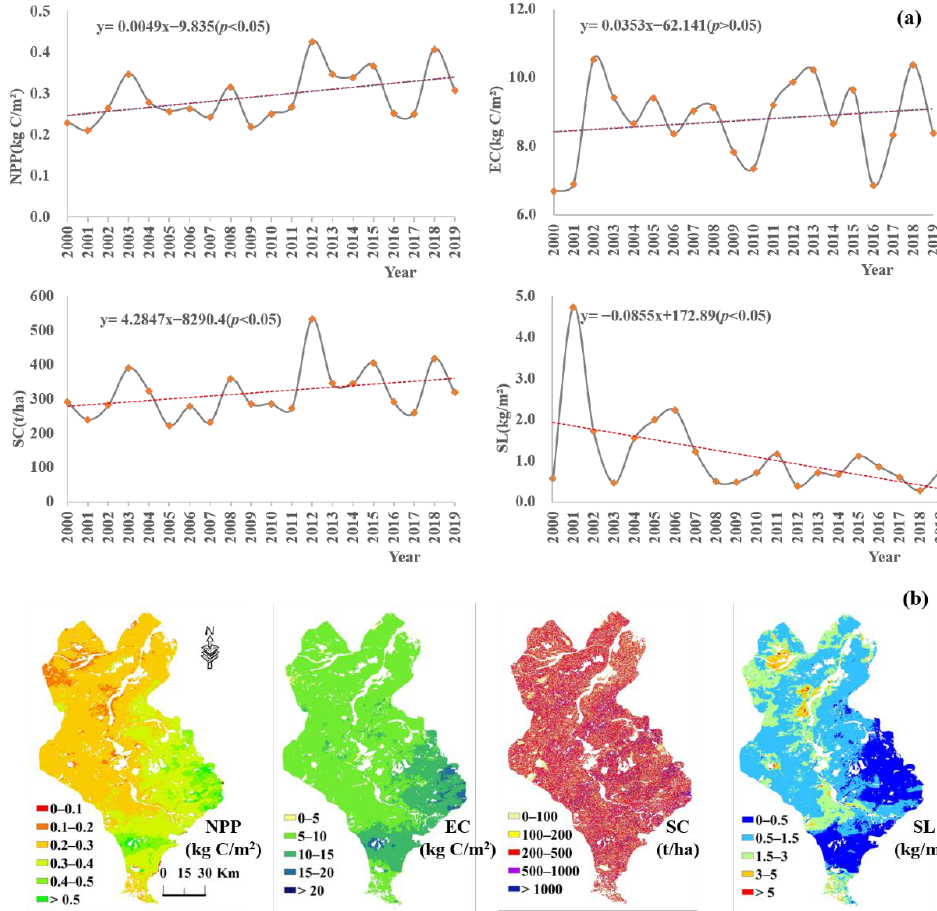
Figure 4. Spatiotemporal of ecosystem services in the study area, from 2000 to 2019. ( a ) Interannual variability; ( b ) spatial distribution of the average value of ecosystem services, from 2000 to 2019. NPP, net primary production (kg C/m 2 ); EC, ecosystem carbon (kg C/m 2 ); SC, soil conservation (t/ha); SL, soil loss by wind (kg/m 2 ).